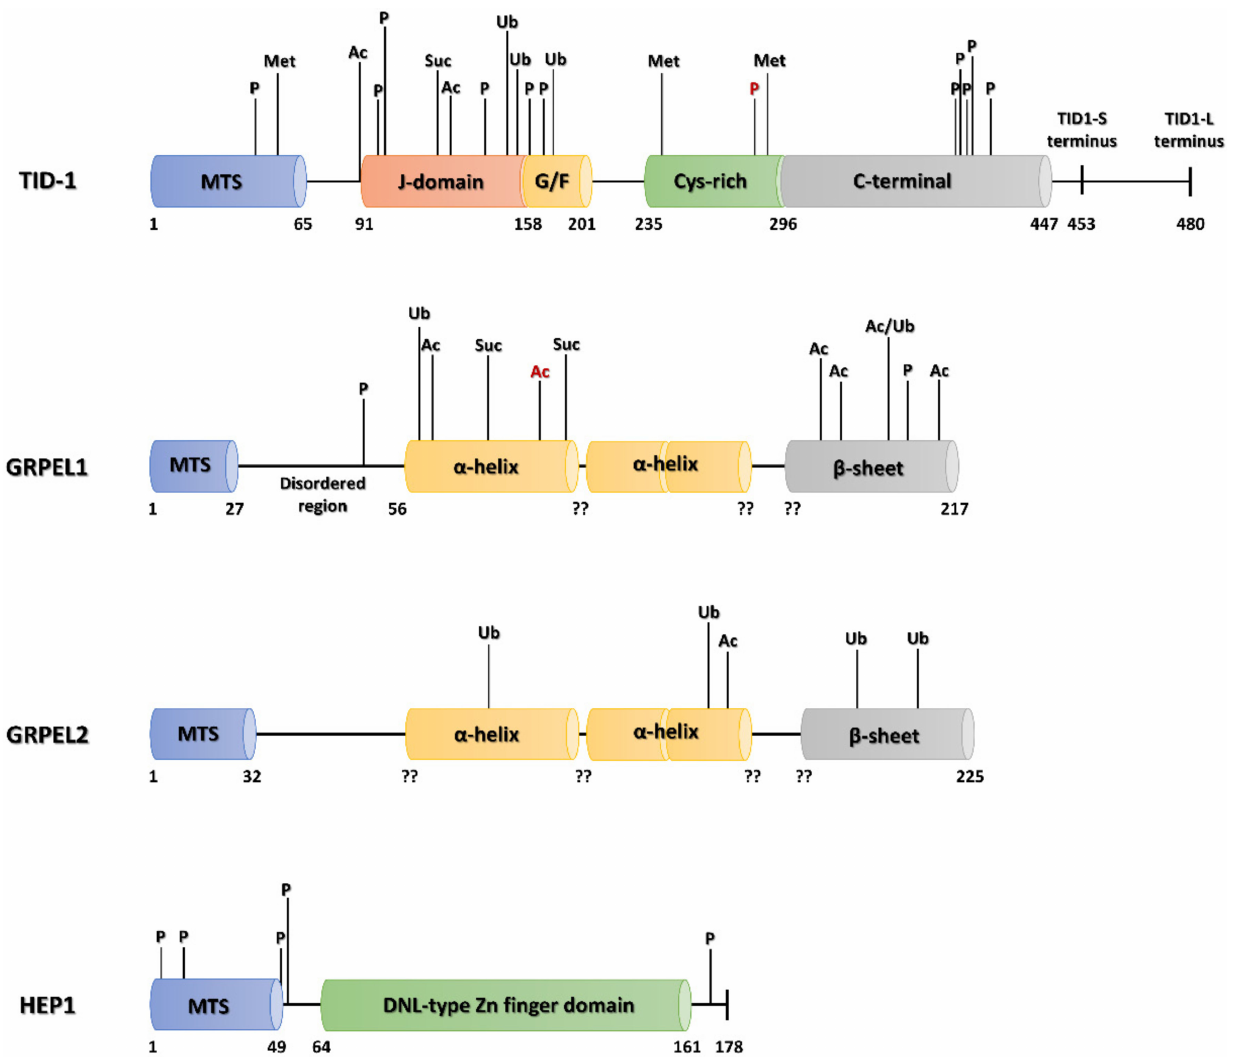
Figure 4. The structural domains of human TID-1, the GRPEL1/2 isoforms and HEP1 with currently known post- translational modifications highlighted [220]. The residues most frequently identified in MS searches for post-translational modifications are colored red. The number below each diagram mark the beginning and end of the major divisions of the protein and help to indicate the position of a given amino acid in the protein sequence. The question marks indicate that for the human homologue, the domain boundaries are not presently